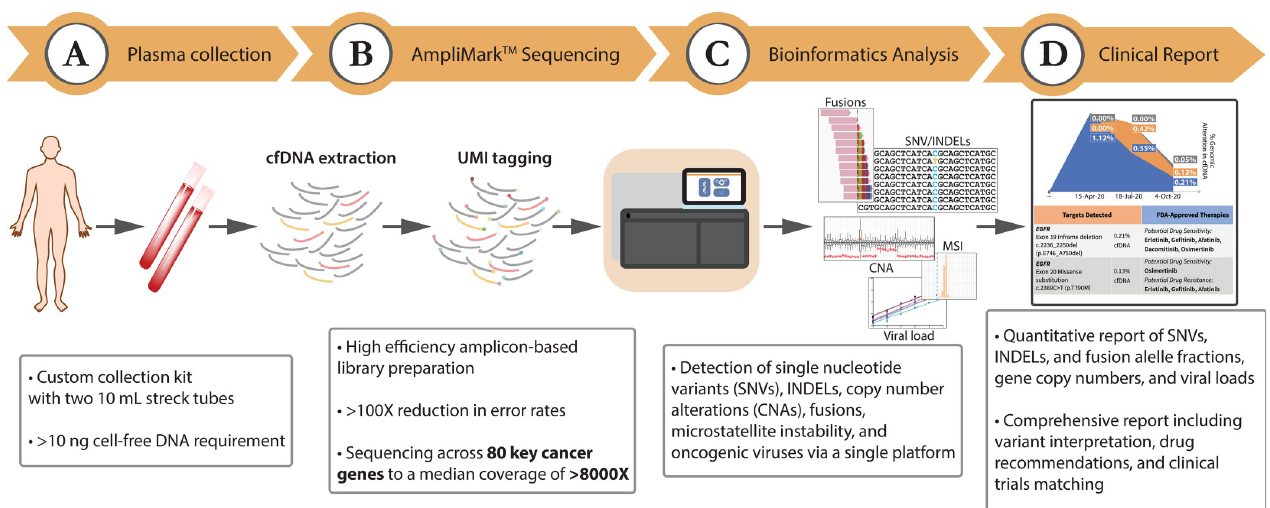
Fig 1. Overview of the LiquidHALLMARK assay workflow. (A) Stabilized whole blood is collected using custom collection kits and cell-free DNA (cfDNA) isolated from plasma. Up to 20 ng of cfDNA is used for library preparation. (B) Targeted genomic regions are tagged with oligonucleotide barcodes and enriched via high efficiency amplicon-based (AmpliMark) library preparation before being sequenced to a median coverage of > 8000X. UMI, unique molecular identifier. (C) Sequencing data is bioinformatically deconvoluted, with molecular barcodes enabling error suppression rates above 100X. (D) Somatic variants and other biomarkers are quantitative reported, with comprehensive interpretation encompassing drug actionability and clinical trial eligibility.